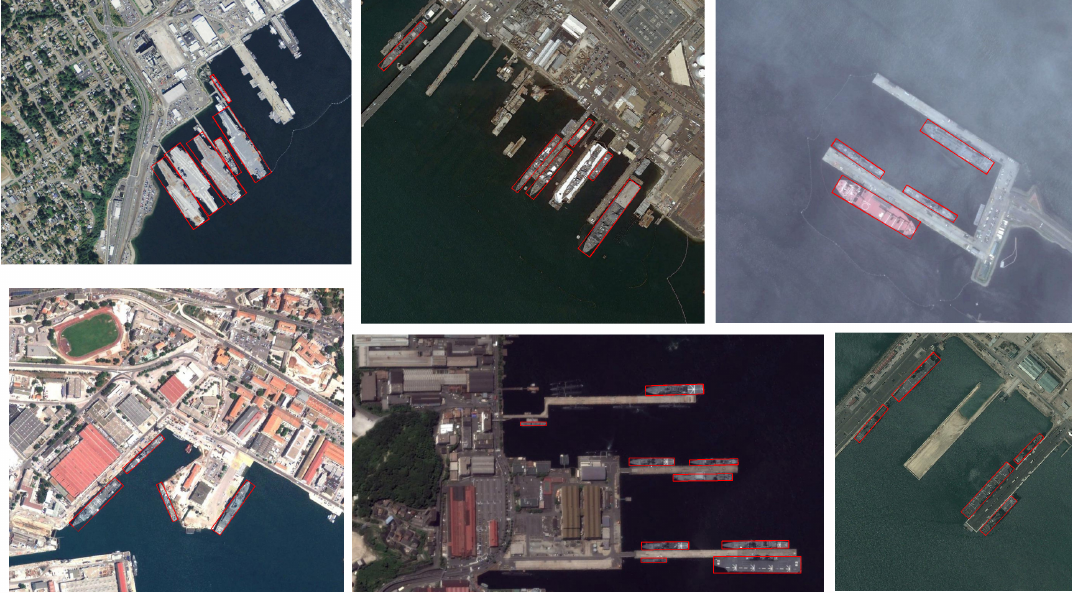
Figure 9. Sample images and manually marked ground truth of the port image dataset collected from Google